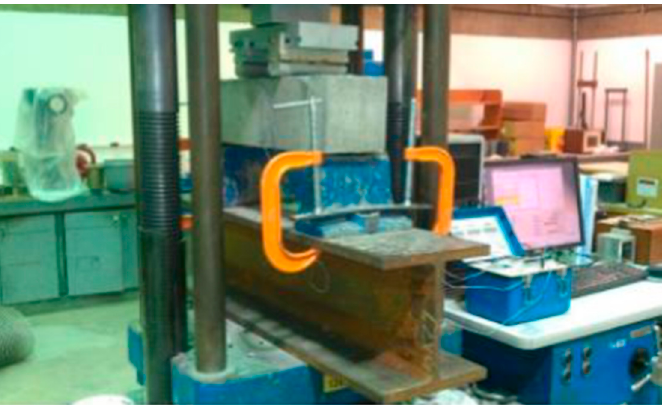
Figure 2. Detailed third-point bending test setup for a typical specimen [Reprinted/adapted with permission from Ref. [37]. 2022, Elsevier]. Table 1. Mix designs of the tested rubber concrete [37].